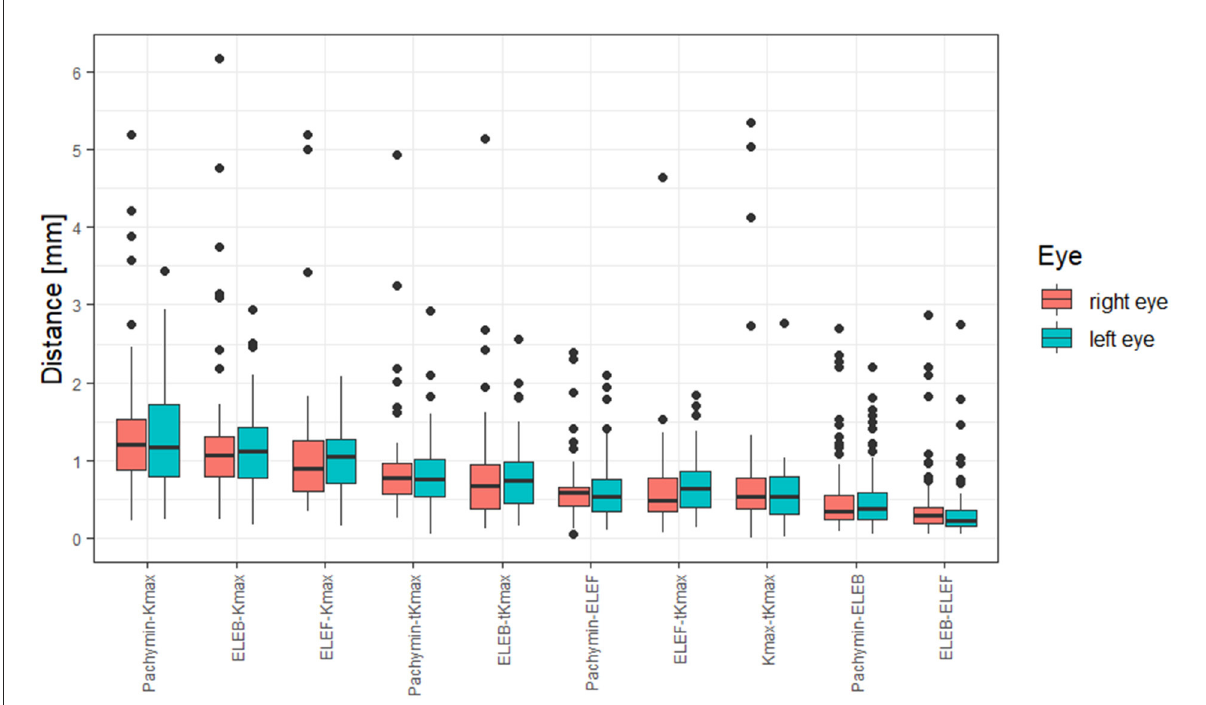
FIGURE2 Box and whisker plot of distances between locations of different tomographic